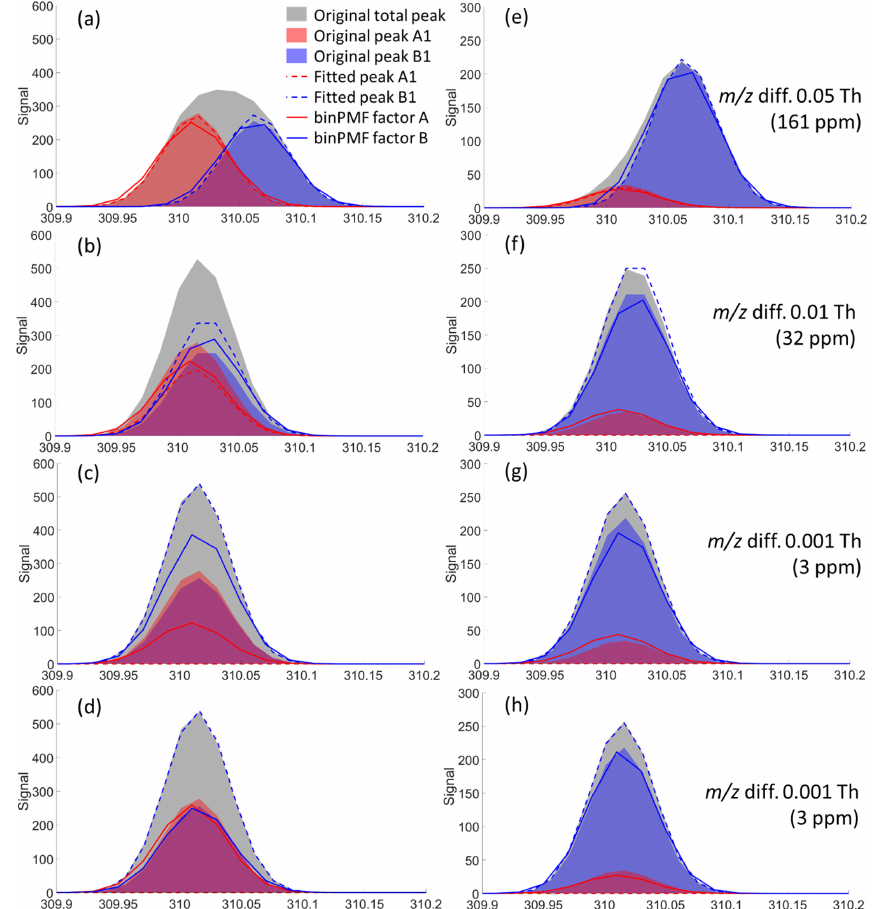
Figure 4. Peak separation results by a traditional HR fitting method (dashed lines) and binPMF (solid lines), at the 79th time point (a–d) and at the 21st time point (e–h) for experiment numbers 1 (a, e) , 5 (b, f) , 10 (c, g) , and 20 (d, h) . The signal intensity ratios of peaks A1 and B1 were about 1 : 1 and 1 : 6, respectively, at the 79th and the 21st time points. Panels (a)–(c) and (e)–(g) are for the one-mass system, while panels (d) and (h) are for the two-mass